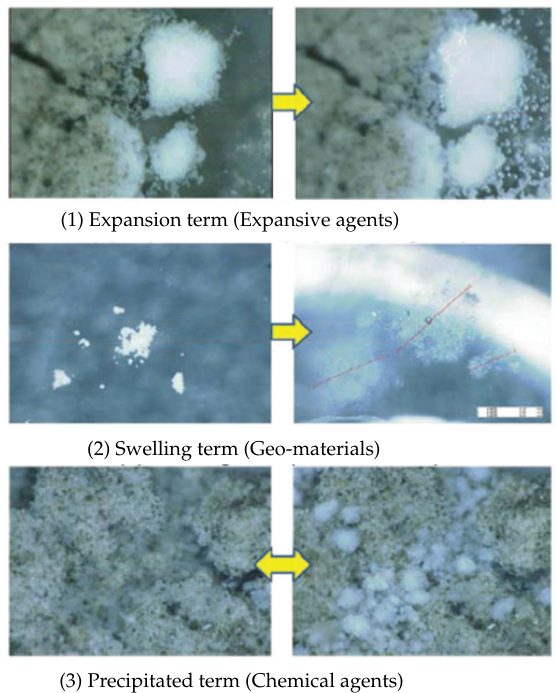
Figure 3. Three main self-healing mechanisms using mineral admixtures. Reproduced with permission from the authors of [79]. Copyright 2010,